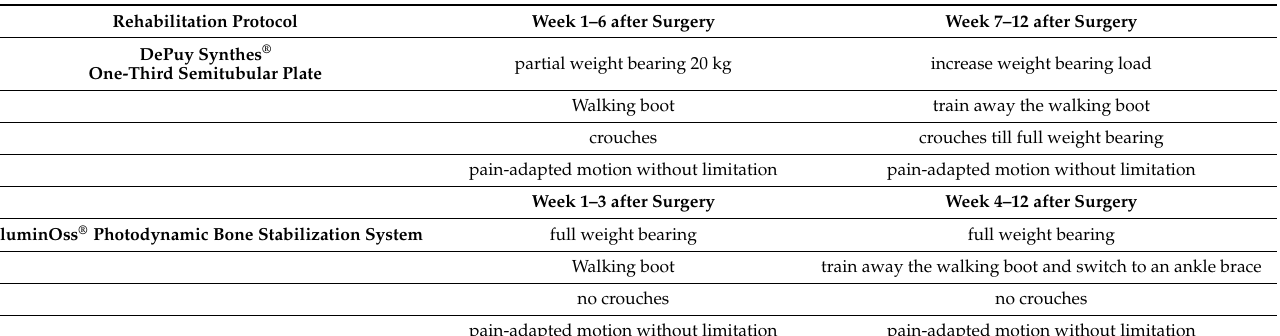
Table 1. Rehabilitation protocols for both study